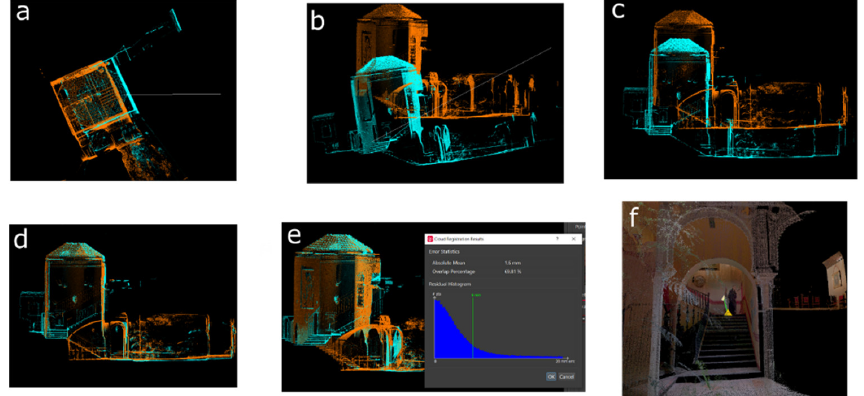
Figure 11. Manual recording of two scans with indication of the fitting error.